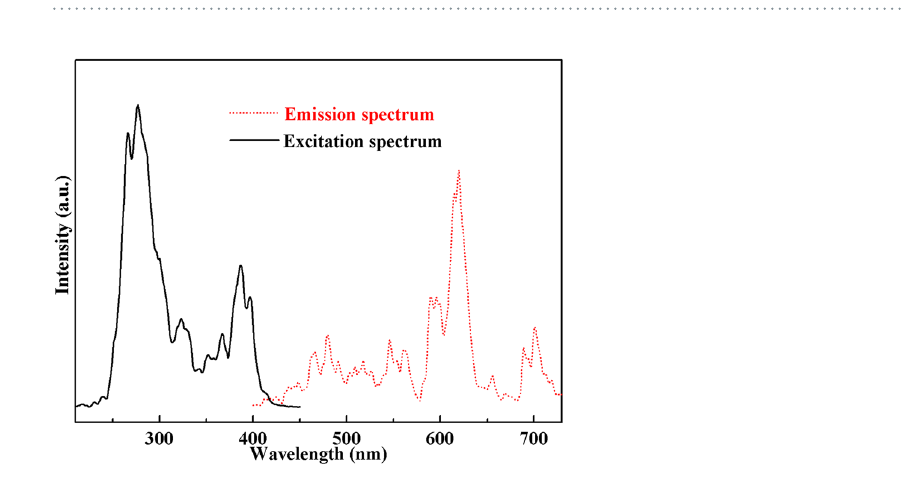
Figure 5. Excitation ( λ em = 620 nm) and emission ( λ ex = 277 nm) spectra of Eu-doped calcium aluminate